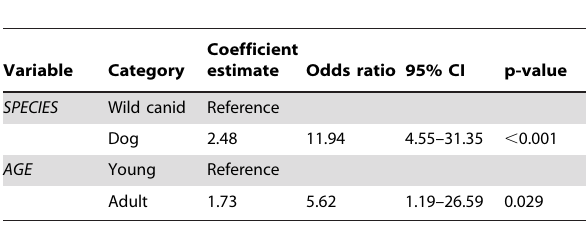
Table 7. Multivariate analysis* of factors associated with Bartonella PCR detection in Iraqi canids.